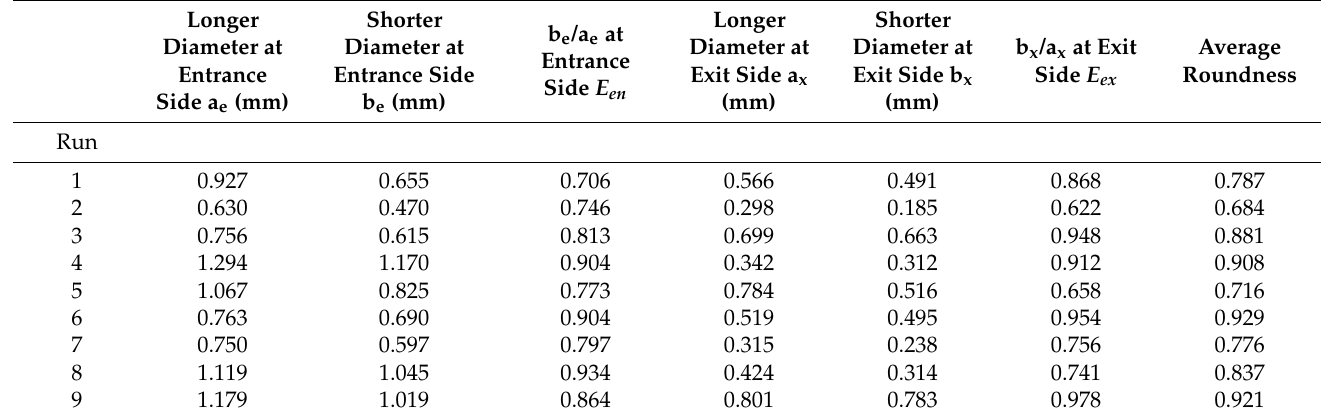
Table A1. Measured data and quality calculation results for roundness with elliptical approximation.